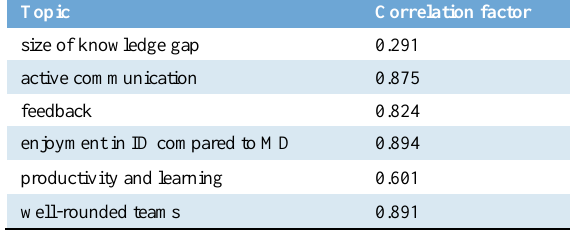
Tab. 1. The correlation between the listed topics, different aspects that may contribute to creativity, and the number of individual ideas averaged over a team.